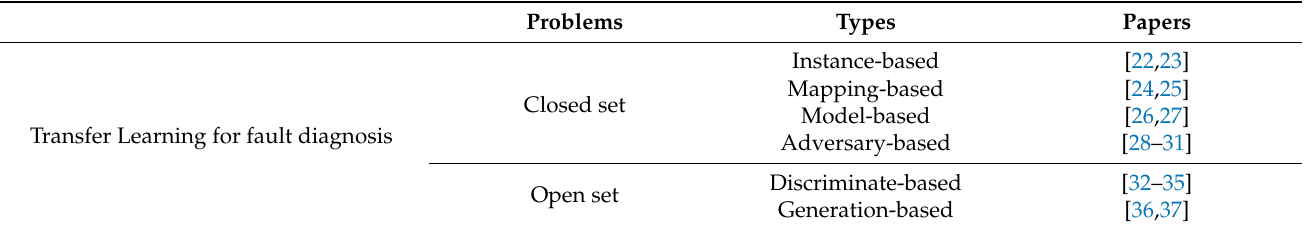
Table 1. The application of TL in fault